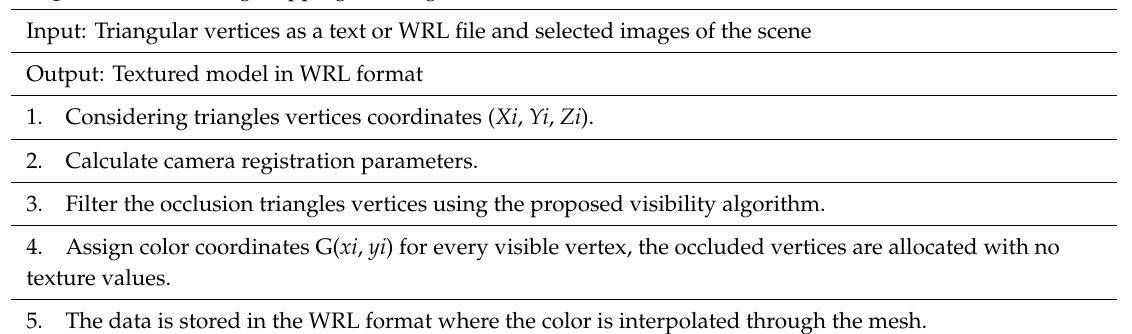
Algorithm 2 Texturing mapping of triangular mesh